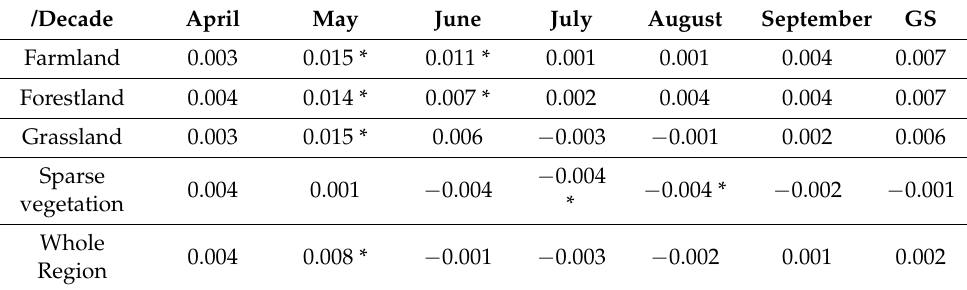
Table 1. NDVI change trend for each land cover type and the whole region in April, May, June, July, August, September, and growing season (GS) from 1982 to 2015. /Decade April GS